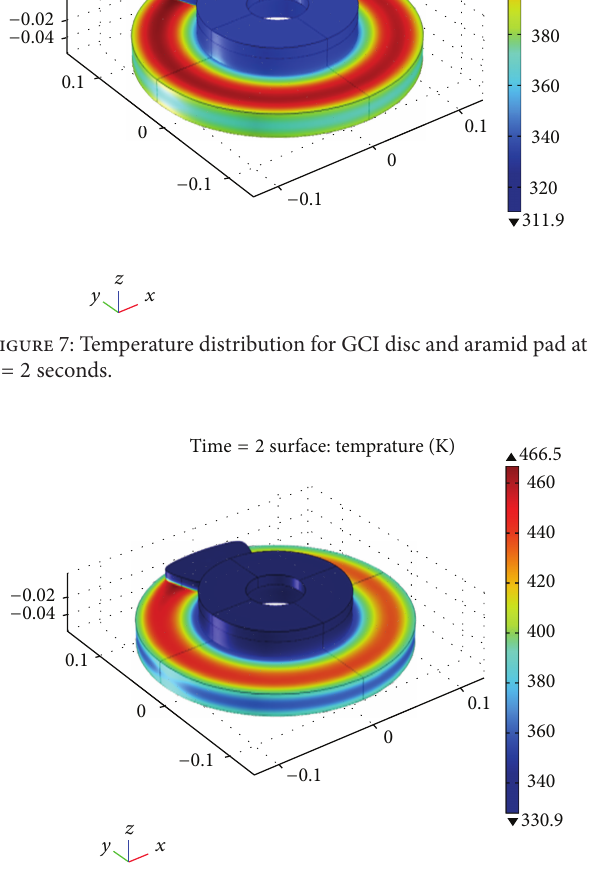
Figure 10: Temperature versus time Plots for AMC brake disc and asbestos and aramid Brake pads.